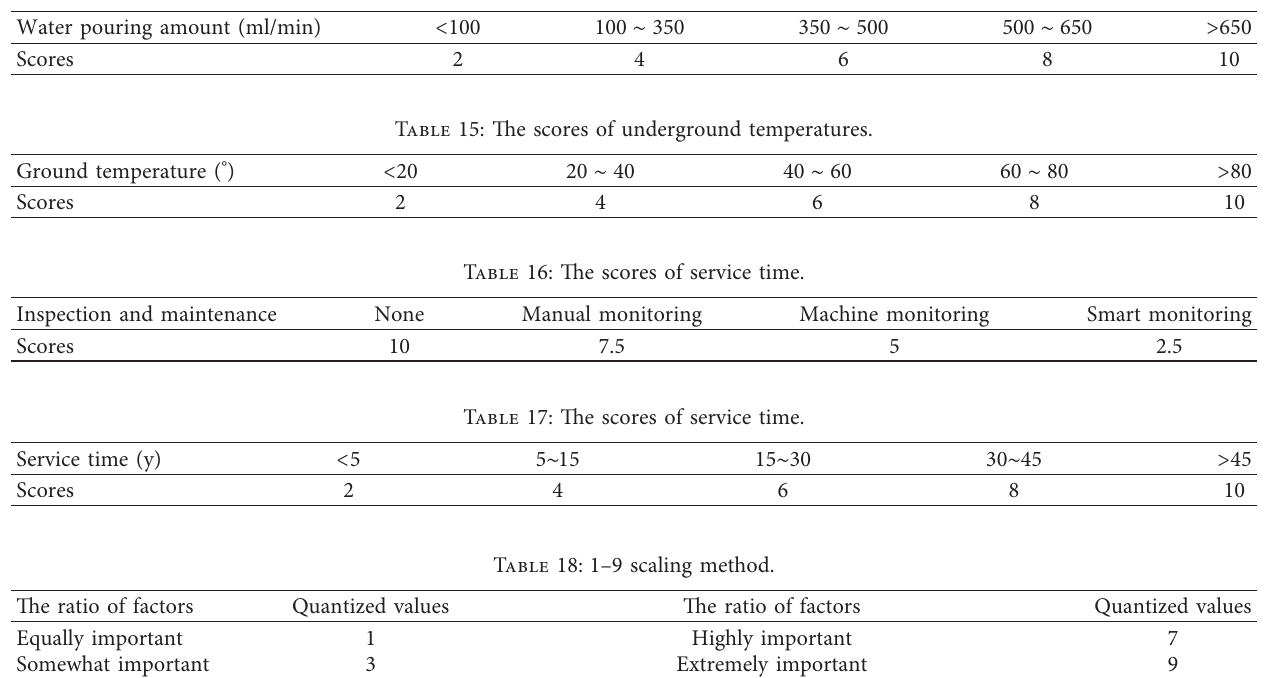
Table 14: The scores of water pouring amount.